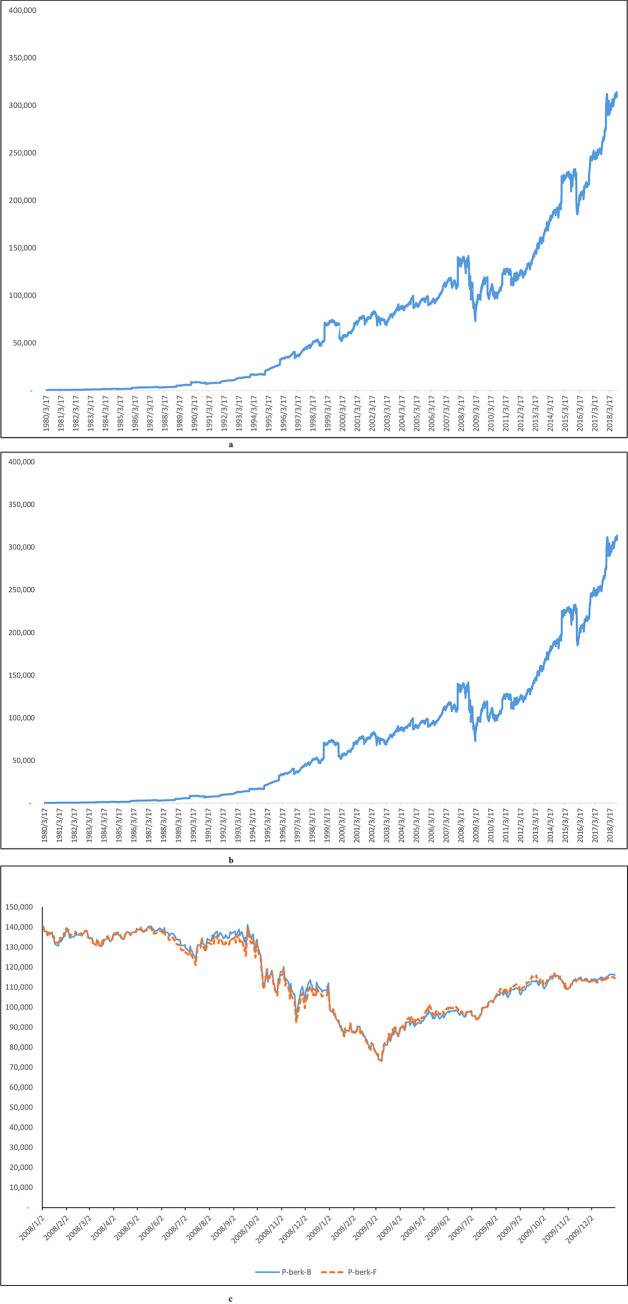
a: Replicating asset price of Buffett-factor model, b: Replicating asset price of five-factor model, c: Replicating asset price of Buffett-factor model and replicating asset price of five-factor model for the sub-period (2008–2009). Fig 3A shows the replicating asset price when the replicating asset is constructed using the Buffet model. Fig 3B shows the replicating asset price when the replicating asset is constructed using the five-factor model. Overall price behavior closely matches the price behavior of the original Berkshire A price. Fig 3C overlays the information presented in Fig 3A and 3B in one plot using a shorter time frame, 2008–2009. This figure shows that the information presented in Fig 3A and 3B, which depict replicating asset price when the replicating asset is constructed using the Buffet- and five-factor models, are not identical to each other. The maximum value of replicating assets price of Buffett- factor model is $141,109; the minimum value is $73,088. The maximum value of the five-factor model is $140,284; the minimum value is $73,375.